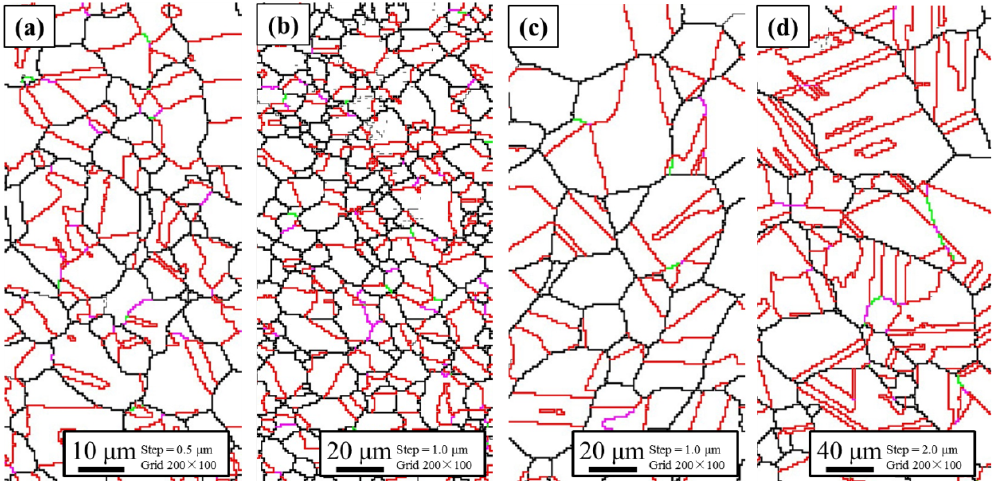
Figure 5. Grain boundary maps of specimens heated at different temperatures: ( a ) 960 ° C, ( b ) 990 ° C, ( c ) 1010 ° C, ( d ) 1040 ° C (Thin black lines represent the low angle grain boundary; thick black lines represent the high angle grain boundary; red, pink, green lines represent Σ 3, Σ 9, Σ 27,twin boundaries respectively).